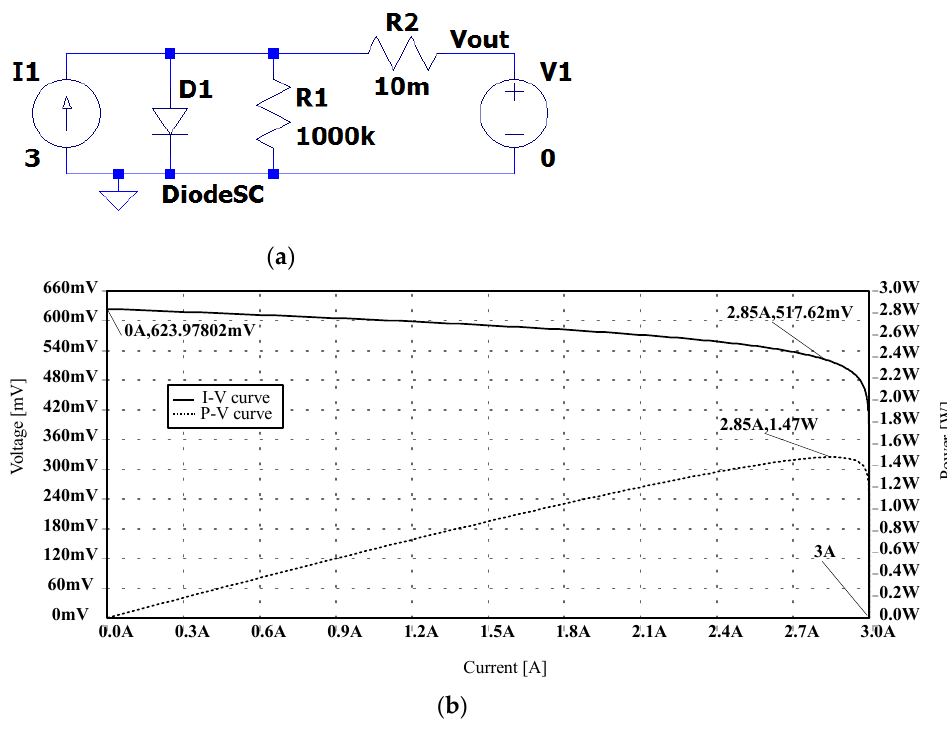
Figure 18. Simulation model of a PV cell: ( a ) diode model circuit; ( b ) I–V and P–V curves.